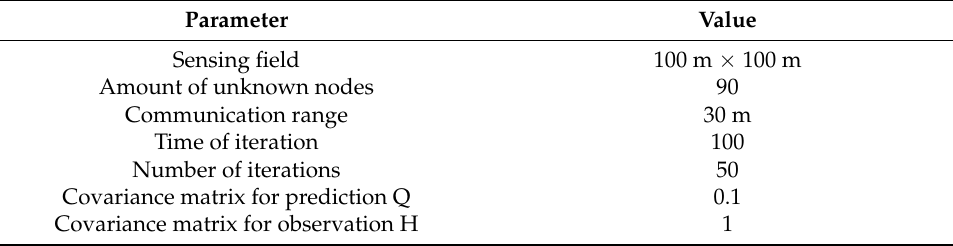
Table 2. Simulation